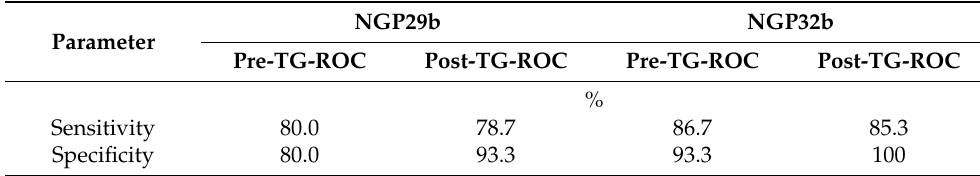
Table 2. Sensitivity and specificity of NGP29b and NGP32b